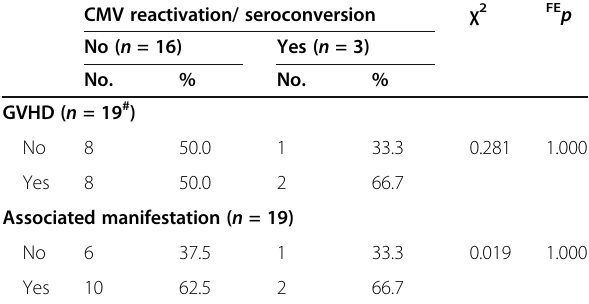
Table 6 Correlation between CMV reactivation and different parameters CMV reactivation/